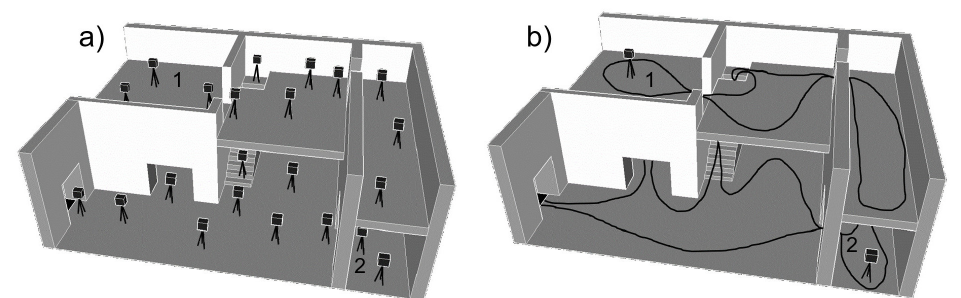
Figure 1. Illustration of registration of Rooms 1 and 2 in two cases: ( a ) TLS demands covering the space between Rooms 1 and 2 with TLS positions in order to register the point clouds of the two rooms together and ( b ) TLS with the support of a SLAM LS only requires TLS scanning positions in Rooms 1 and 2, and the area between them can be collected with a SLAM LS (the black line in the figure).